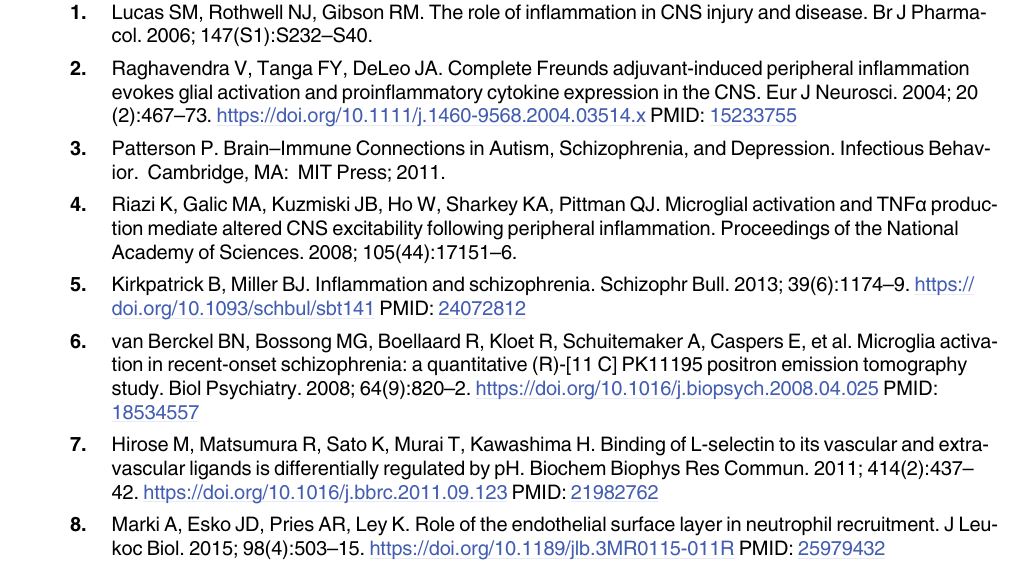
S2 Table. Correlation between the individual selectins and NIH Toolbox Cognitive Mea- sures. S3 Table. Correlation between the individual selectins and CRP and BMI. S4 Table. Comparison of plasma selectins between male and female patients and controls